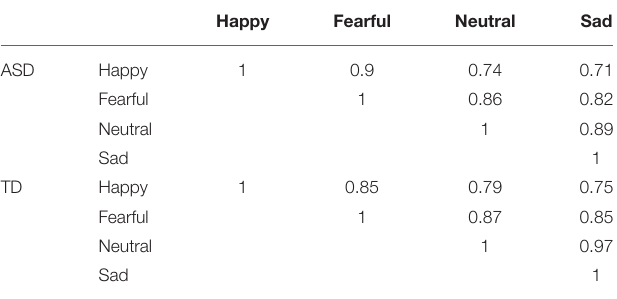
TABLE 5 | Confusion matrix of emotion categorization in each group. Group